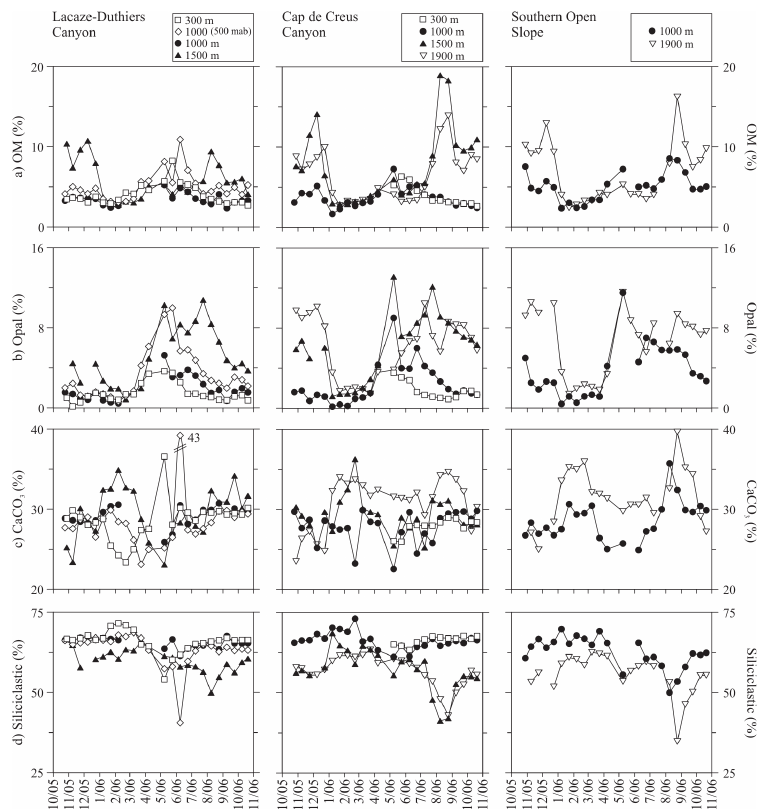
Fig. 5. Temporal evolution of (a) organic matter (OM), (b) opal, (c) calcium carbonate (CaCO 3 ) , and (d) siliciclastic fractions, in the Lacaze- Duthiers Canyon (LDC), Cap de Creus Canyon (CCC) and Southern Open Slope (SOS) for different water depths stations: 300m (white squares), 1000m (black dots), 1000m (500mab) (white rhombus), 1500m (black up triangles) and 1900m (white down triangles).